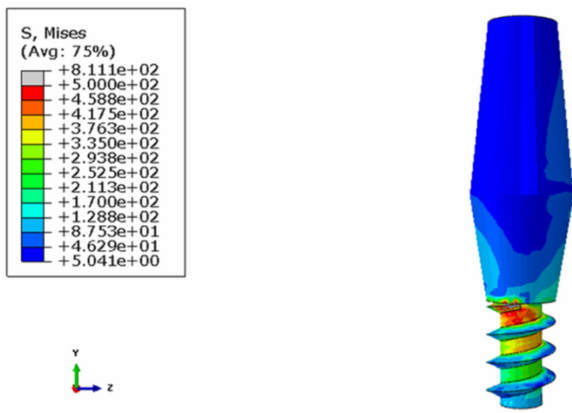
Figure 7. Stress distribution in the abutment.